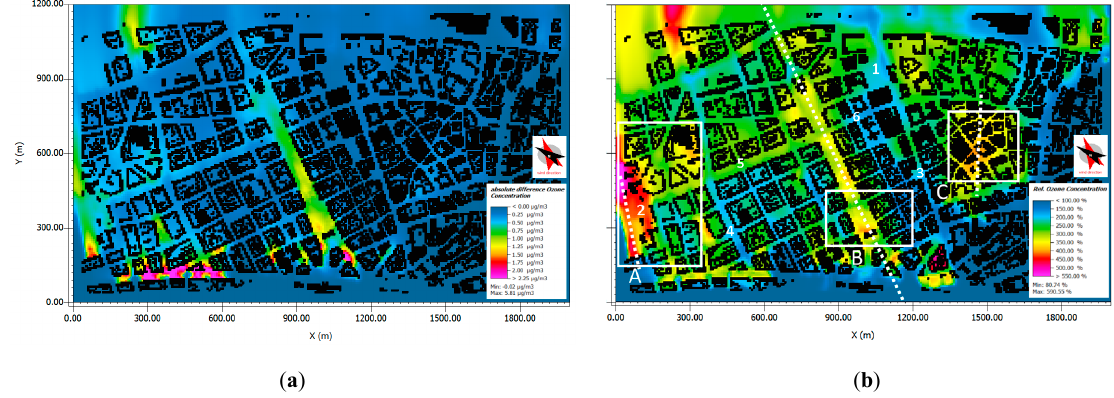
Figure 12. Model domain of 7.5 km with ( a ) absolute and ( b ) relative difference in ozone concentration at screen height. White boxes in ( b ) indicate three special areas of interest (SAI) and six example areas (EAs). Red dotted lines indicate cross-sections to be analyzed.